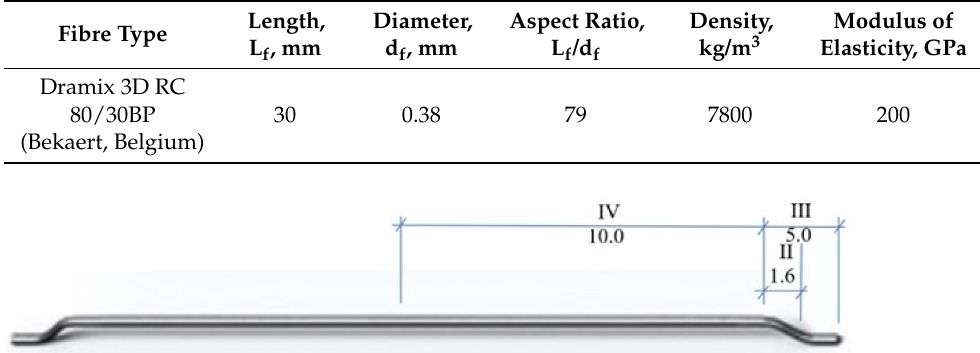
Table 1. Specification of steel fibers according to supplier’s data.